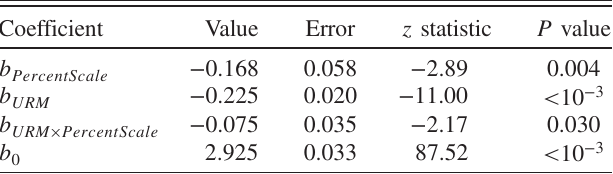
TABLE III. The coefficients from an HLM fit to Eq. (2) are shown along with their standard errors, z statistics, and P